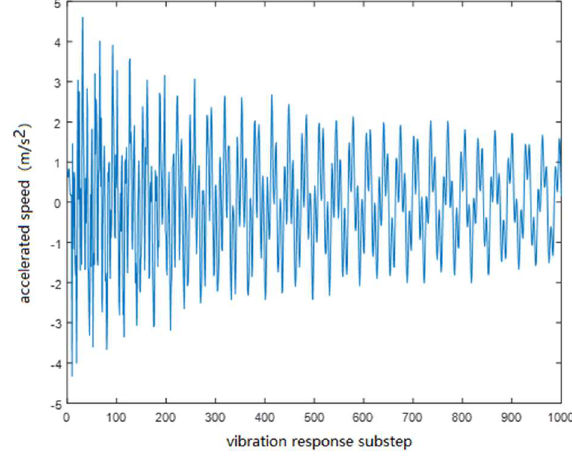
Figure 3. Response of the 36th lower node under full−load impact at the 36th upper node.